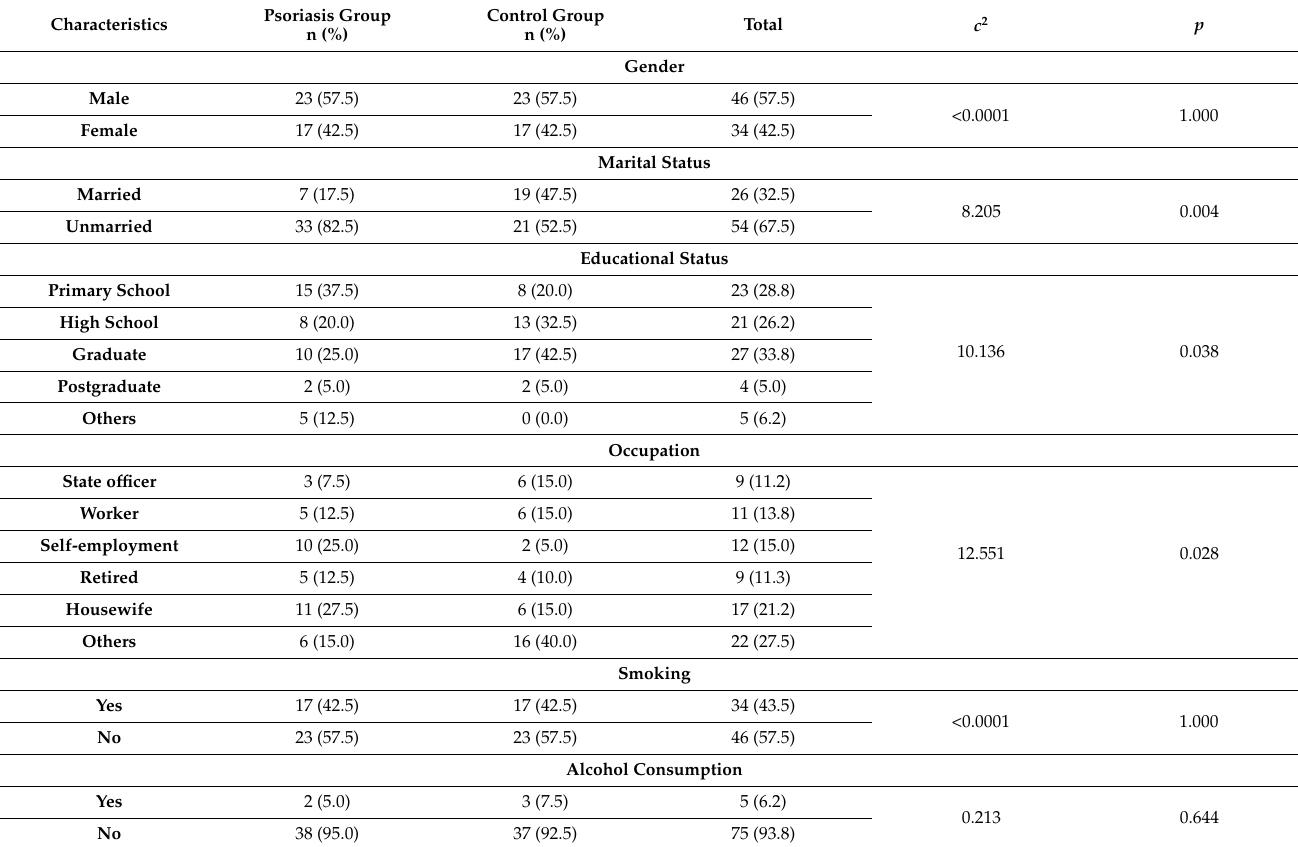
Table 1. Comparison of socio-demographic characteristics of the groups.